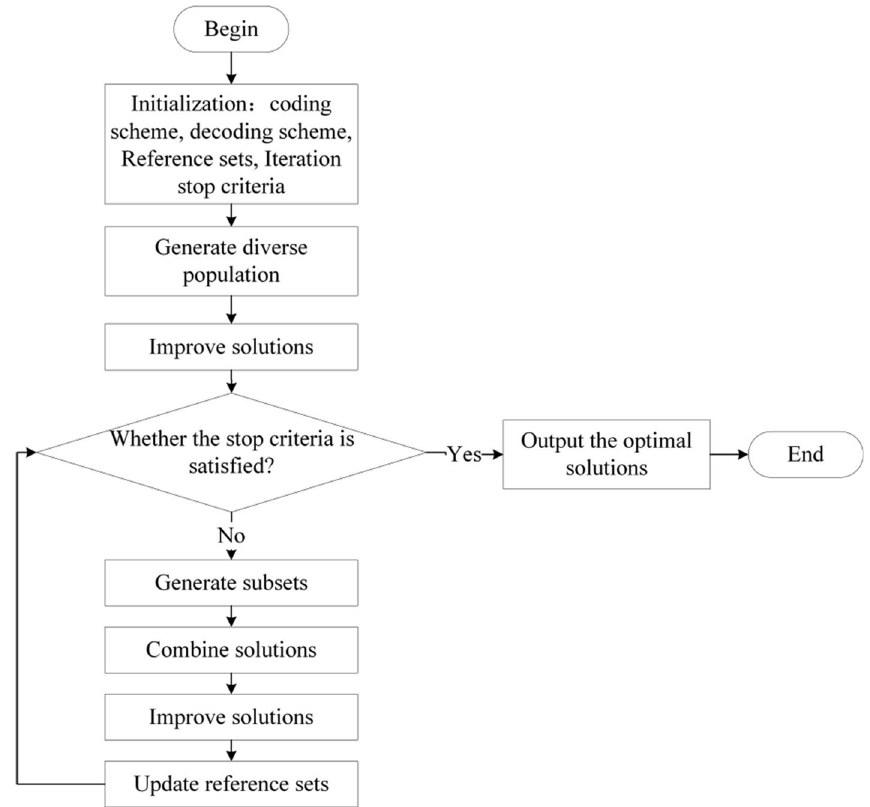
Fig. 2 The flow chart of scatter search